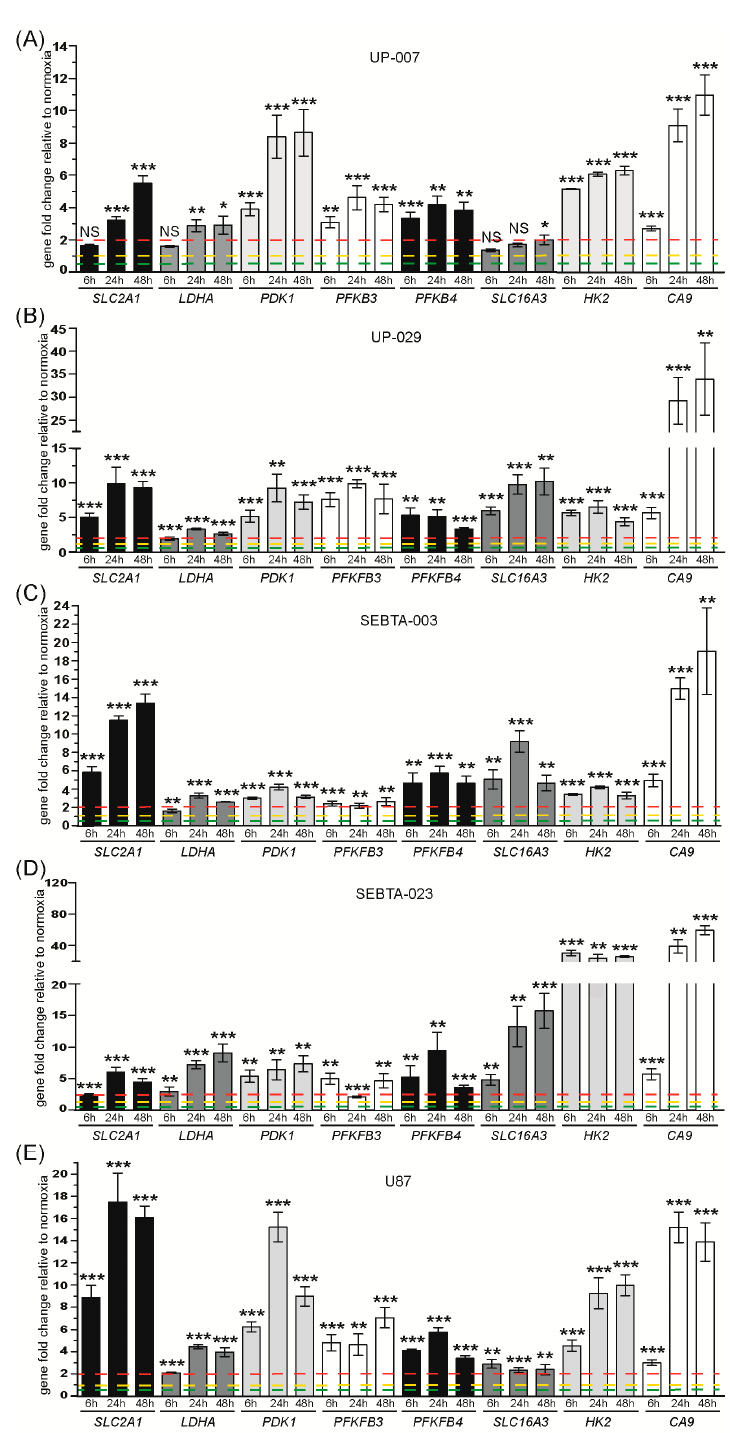
Figure3. AnalysisofglycolysisrelatedgenesinhypoxicGBcells. ( A )UP-007; ( B )UP-029; ( C )SEBTA-003; ( D ) SEBTA-023; or ( E ) U87 cells were incubated under normoxia (21% O 2 ) or hypoxia (1% O 2 ) for the times indicated. RNA extraction was performed and gene expression was determined by RT-qPCR. Gene expression levels were normalized to RPLP0 mRNA using the 2 − ∆∆ CT method [13]. Error bars represent the Standard Deviations obtained from the median value of at least three independent experiments, performed in triplicate. Statistical analysis was done using two-tailed Student’s t-test, comparing each hypoxia time-point to the respective normoxic control. In every case a p value of less than 0.05 (*), less than 0.01 (**), and 0.001 (***) was considered statistically